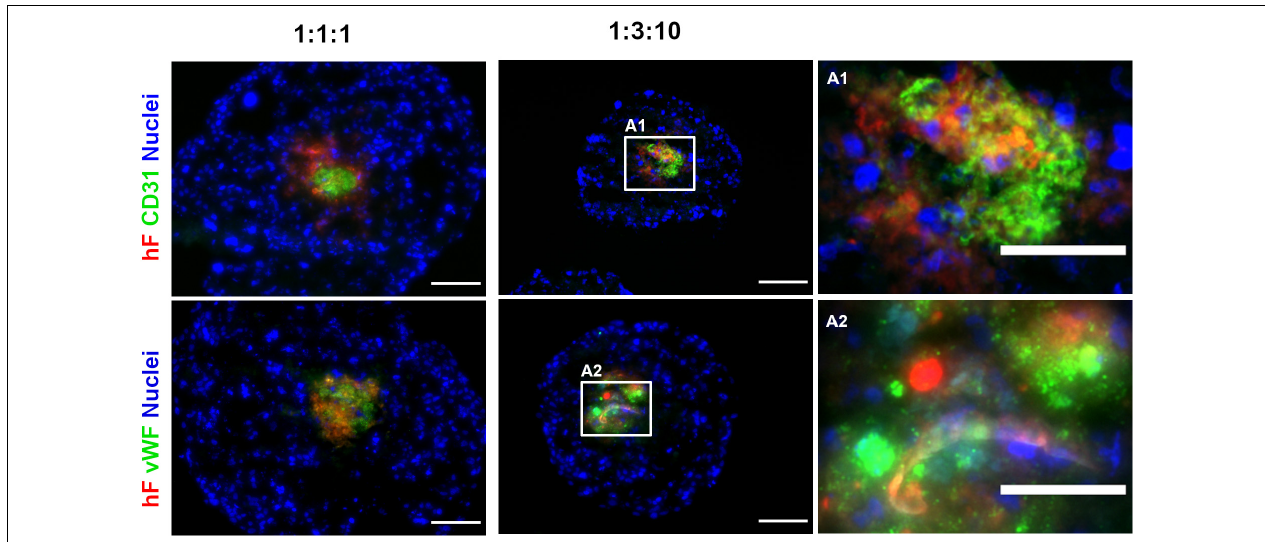
FIGURE 4 | Endothelial cells maintained their identity and phenotype in triple heterotypic spheroids after 30 days of culture. Immunofluorescence microscopy on cryosections of spheroids, collected at day 30 (2 days of static culture followed by 28 days of agitation-based culture, rotational speed of 100 rpm). Detection of the EC markers, CD31 (green) and von Willebrand factor (vWF, green); nuclei labeled with DAPI (blue). Spheroids generated by seeding 6,000 cells per well of HCC1954 breast tumor cells (TC), human dermal fibroblast, labeled with PKH26 (hF, red); HUVEC (EC), at TC:hF:EC ratios of 1:1:1 and 1:3:10. Images are representative of the 5–10 spheroids assessed per condition, in each of the three independent experiments performed. Left and middle panels: scale bar, 100 µ m; right panel (A1,A2) are high-magnification insets of the regions indicated by the white squares in the middle panel: scale bar, 50 µ m.